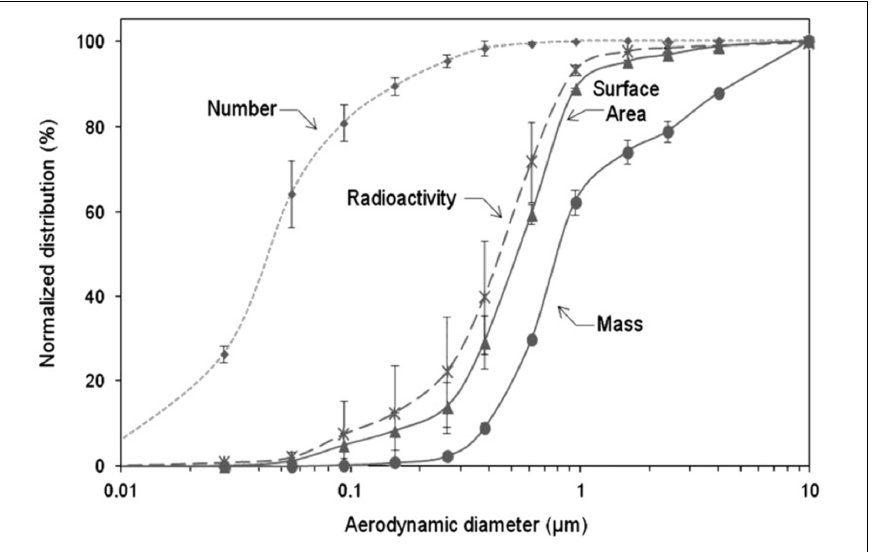
Figure 9. Aerodynamic size distributions (cumulative) of Technegas aerosol using an ELPI and gamma counter. Reprinted/adapted with permission from Ref. [27]. 2013, Elsevier.